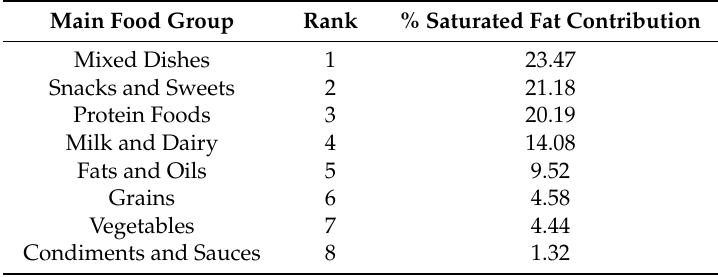
Table 14. Food sources of saturated fat contribution in the total U.S. diet, adults ≥ 51 years old ( n = 4522; gender combined; daily intake data; NHANES 2011–2014; main food groups contributing <1.0% not reported; data are Day 1